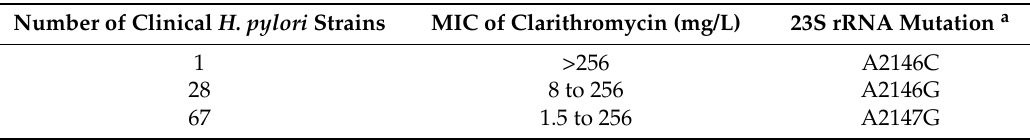
Table 1. Point mutations identified by WGS in the 23S rRNA gene at nucleotide positions, A2146 and A2147, in 96 clarithromycin resistant H. pylori isolates and their corresponding MICs. Number of Clinical H. pylori Strains MIC of Clarithromycin